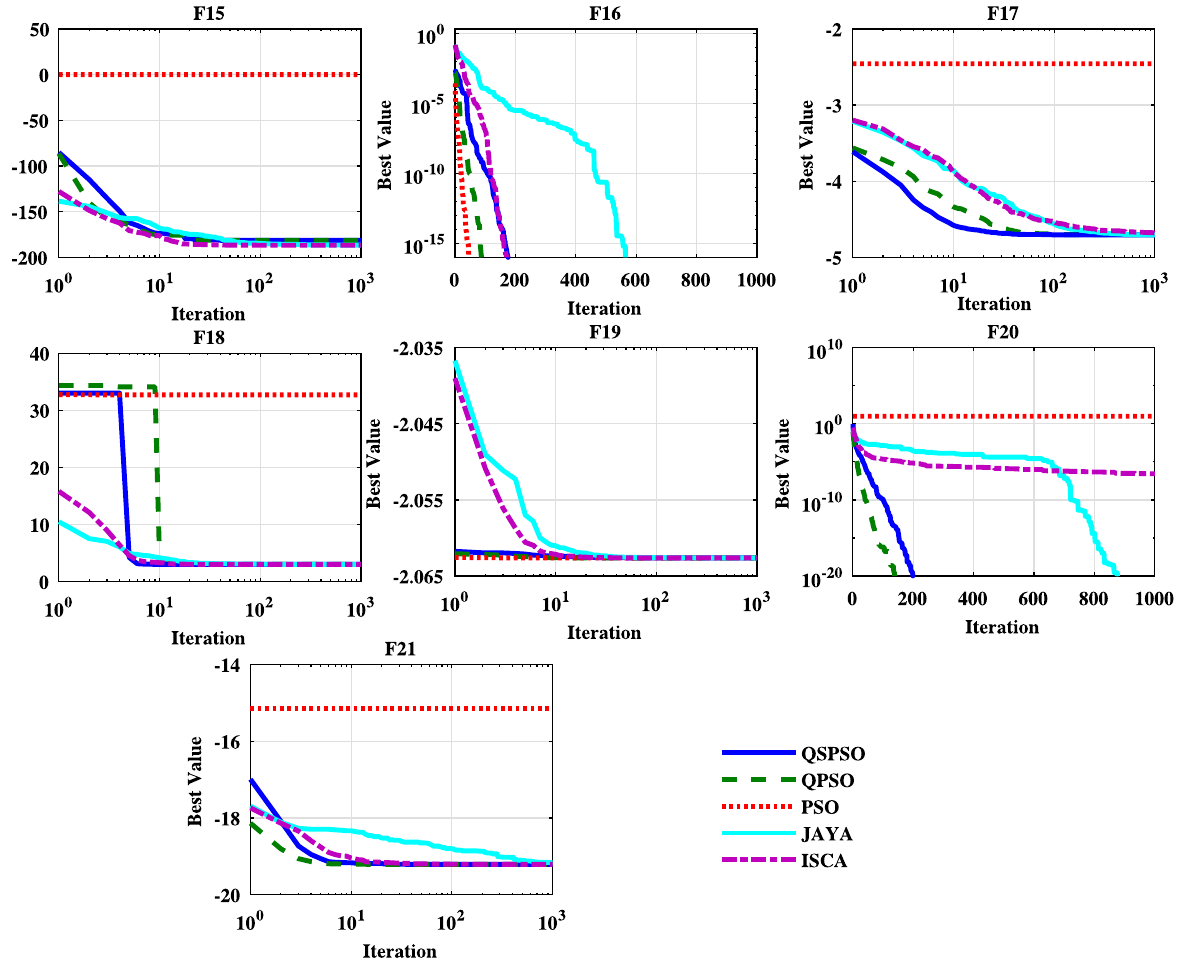
Figure 7. Convergence curves of the fixed-multimodal test